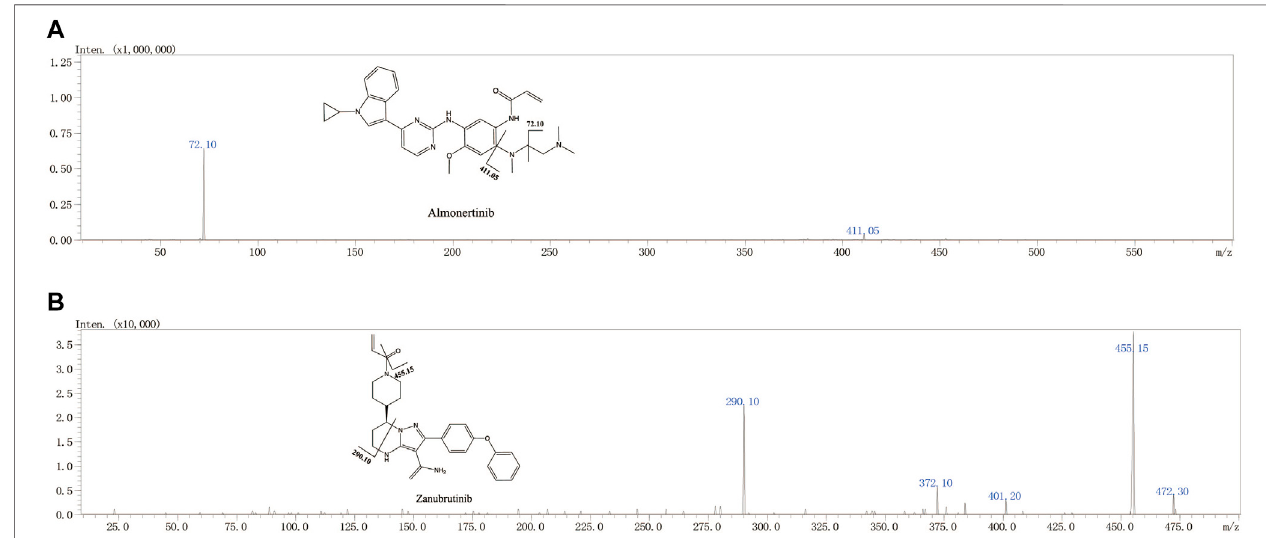
FIGURE 1 | The chemical structures and Mass spectra of almonertinib and IS in the present study.